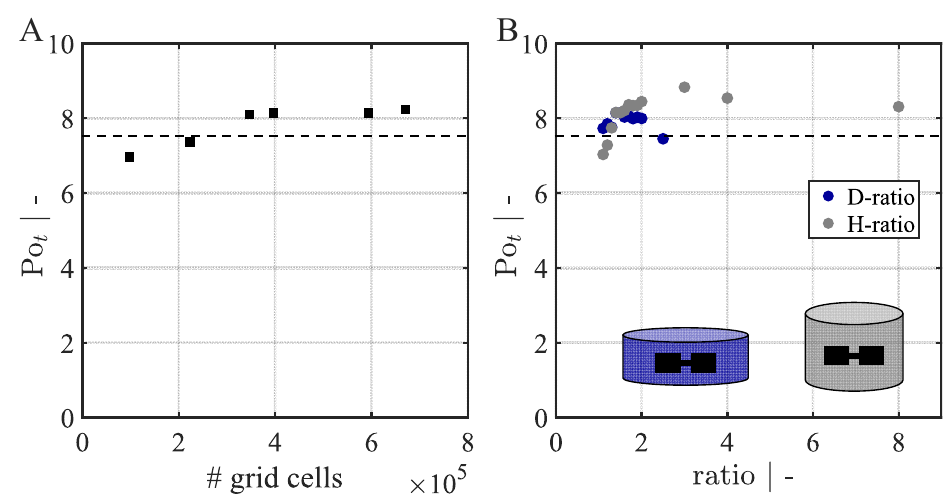
Figure 2. Mesh study and variation of rotating reference frame volume. Evolution of power number by torque over number of grid cells for a fixed rotating reference frame volume ( A ) and depending on the ratio of impeller diameter or height to diameter or height of the RRF volume respectively ( B ) with the experimental value of Po = 7.5, shown as dashed